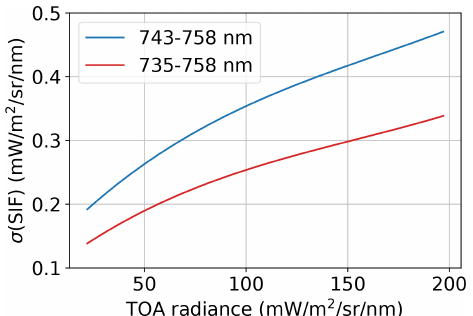
Figure 3. Empirical radiance– σ (SIF) curves used for the calcula- tion of 1 σ SIF retrieval errors in the operational